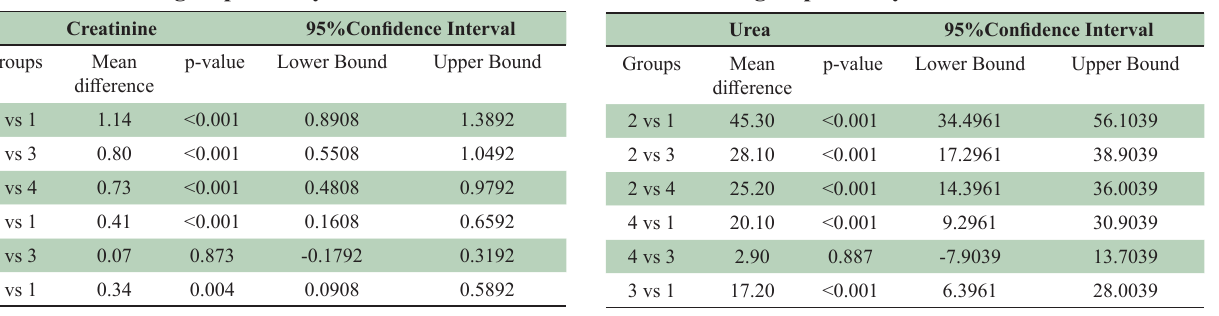
Table-III: Post-Hoc Tukey test showing a comparison of creatinine between groups on day 35.